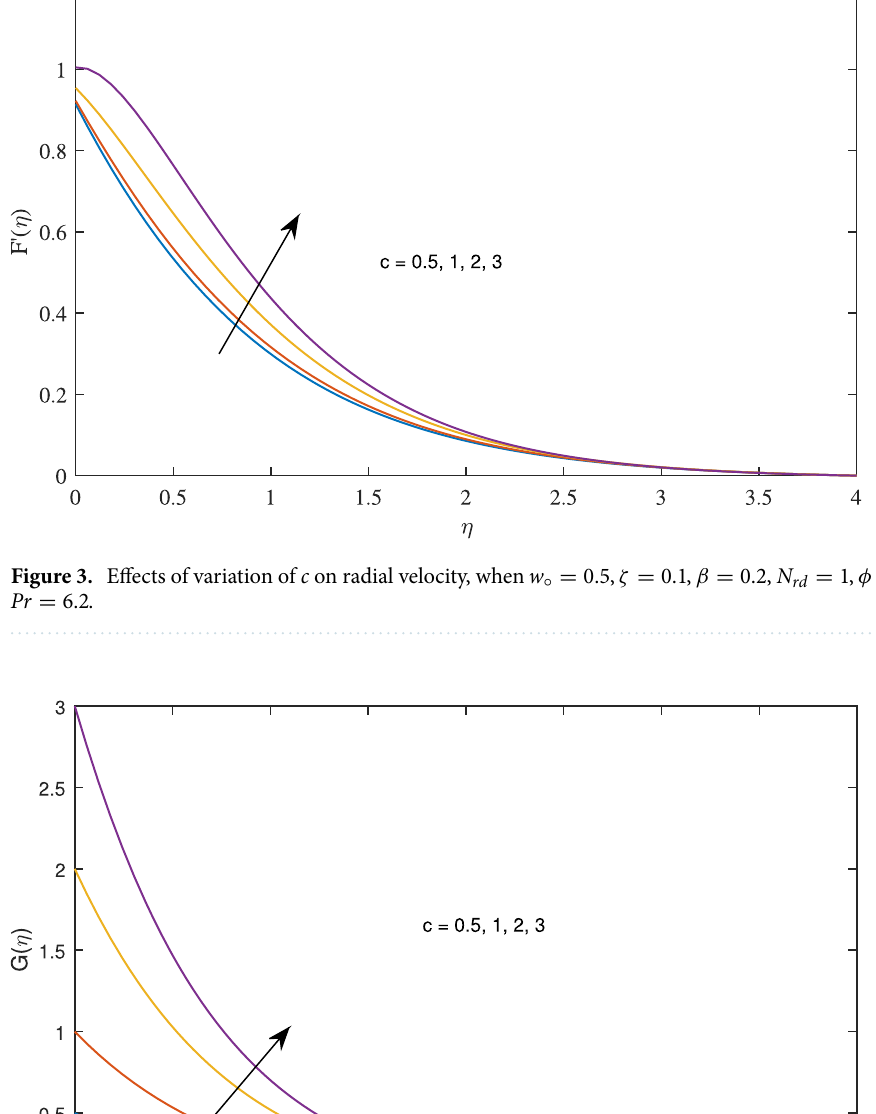
0.1 , β 0.1 and 0.5 , ζ 0.2 , N 1 , φ rd = = = = ◦ =